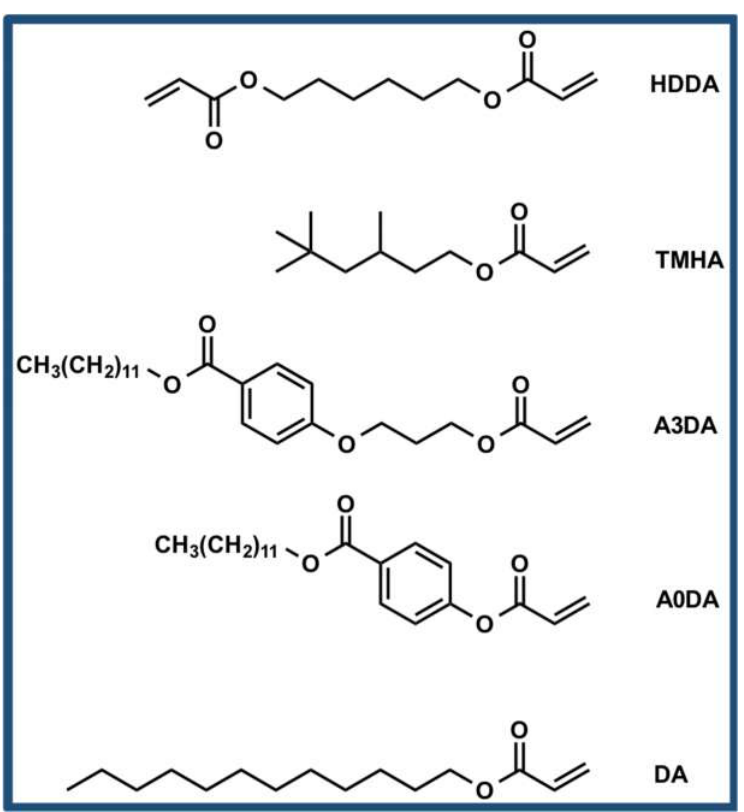
Figure 1. Chemical structure of monomers used to prepare polymer dispersed liquid crystals (PDLCs).